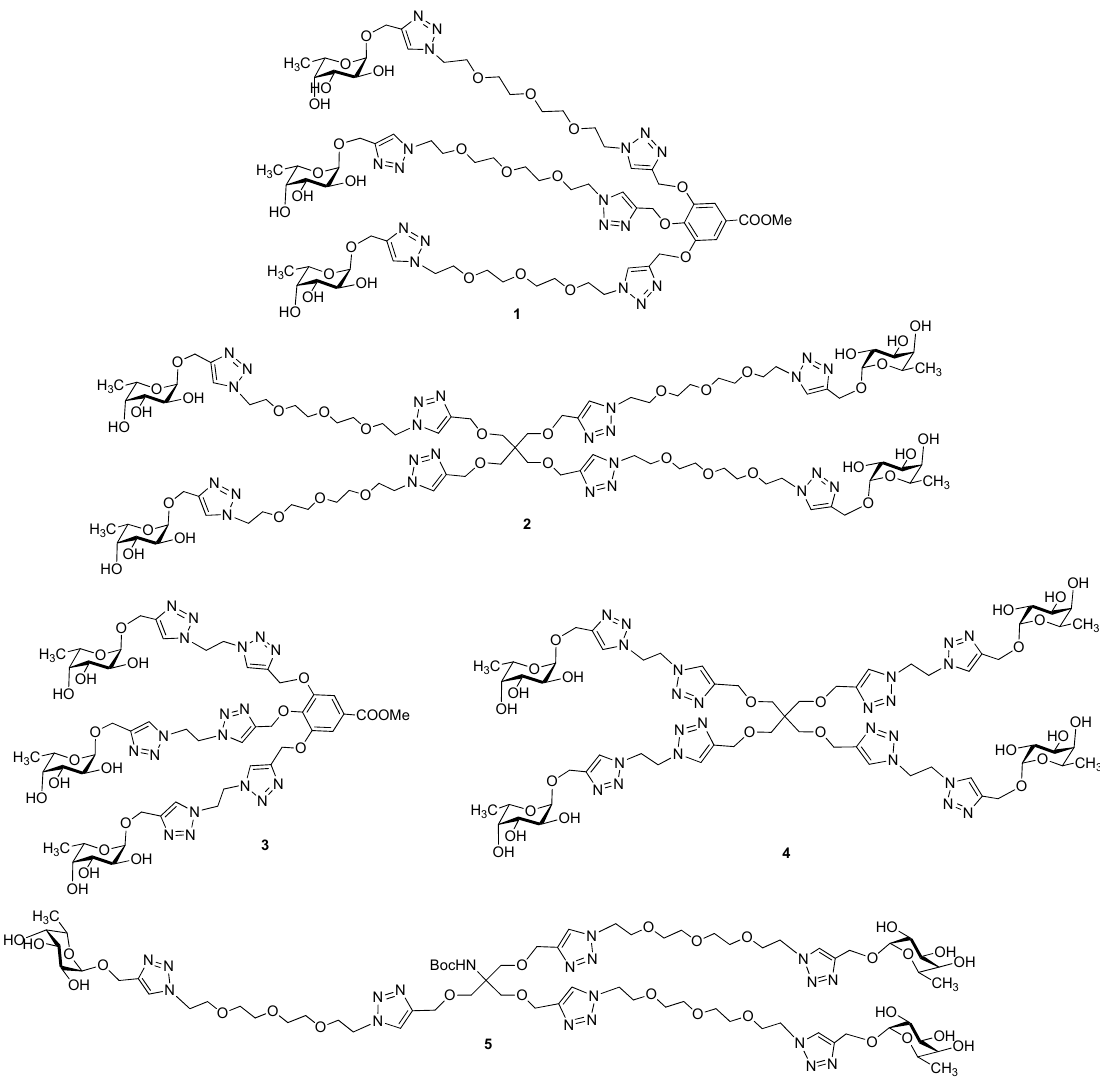
Scheme 1. Chemical structures of multivalent glycoclusters containing α - L -fucosides.